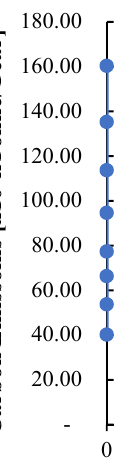
Figure 5. Impact of CO 2 price on carbon emissions.